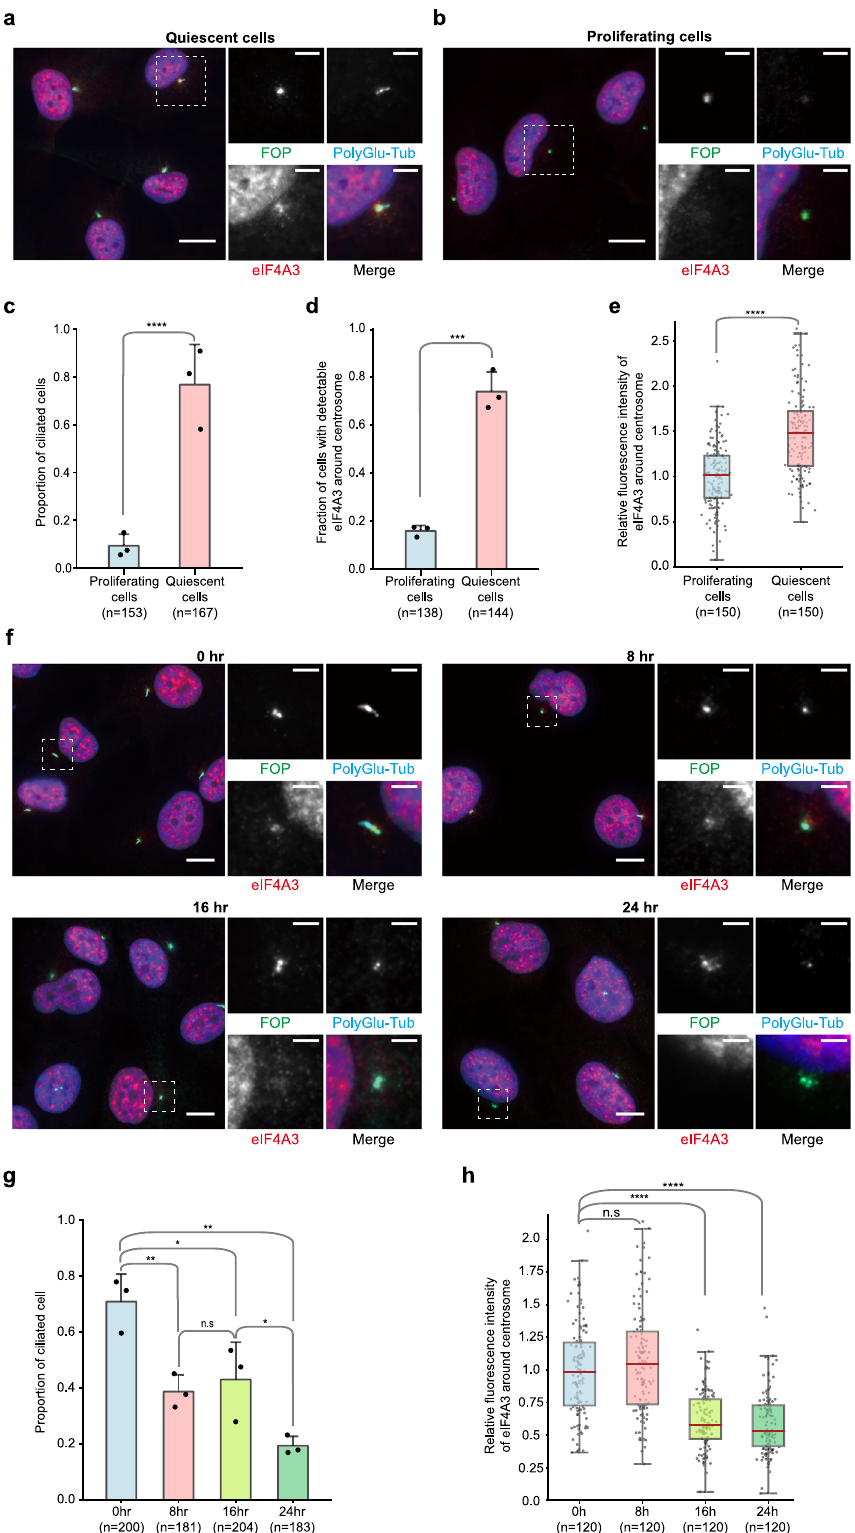
nocodazole for two hours, a well-known microtubule destabilizer, microtubules disappeared (Supplementary Fig. 6a, b). However, poly-glutamylated tubulin immunostaining of both centrioles and cilia was not signi fi cantly affected (Fig. 4a). In contrast, this treatment reduced the fl uorescence intensities of eIF4A3 and Y14 around centrosomes, by 60% and 50%, respectively (Fig. 4a, d